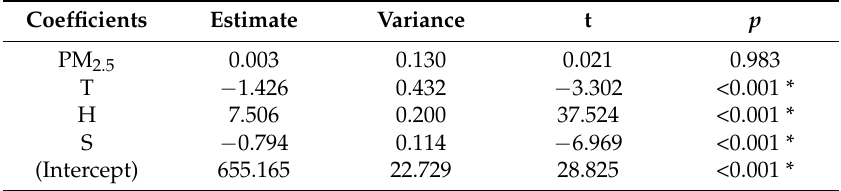
Table 2. Multiple regression analysis results by R (T represents temperature, H represents humidity, S represents total radiation).